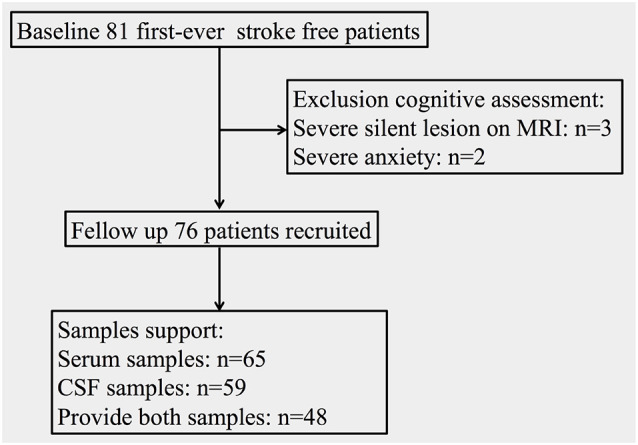
Flowchart of the population and samples support situation.